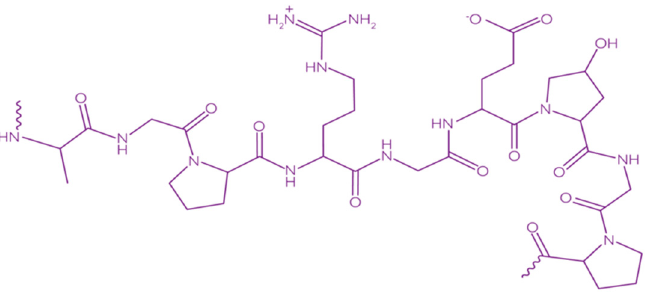
Figure 9. Chemical structure of gelatin [148]. Reproduced with permission from Kariduraganavar, M.Y., et al., Natural and Synthetic Biomedical Polymers; published by Elsevier Inc., 2014.